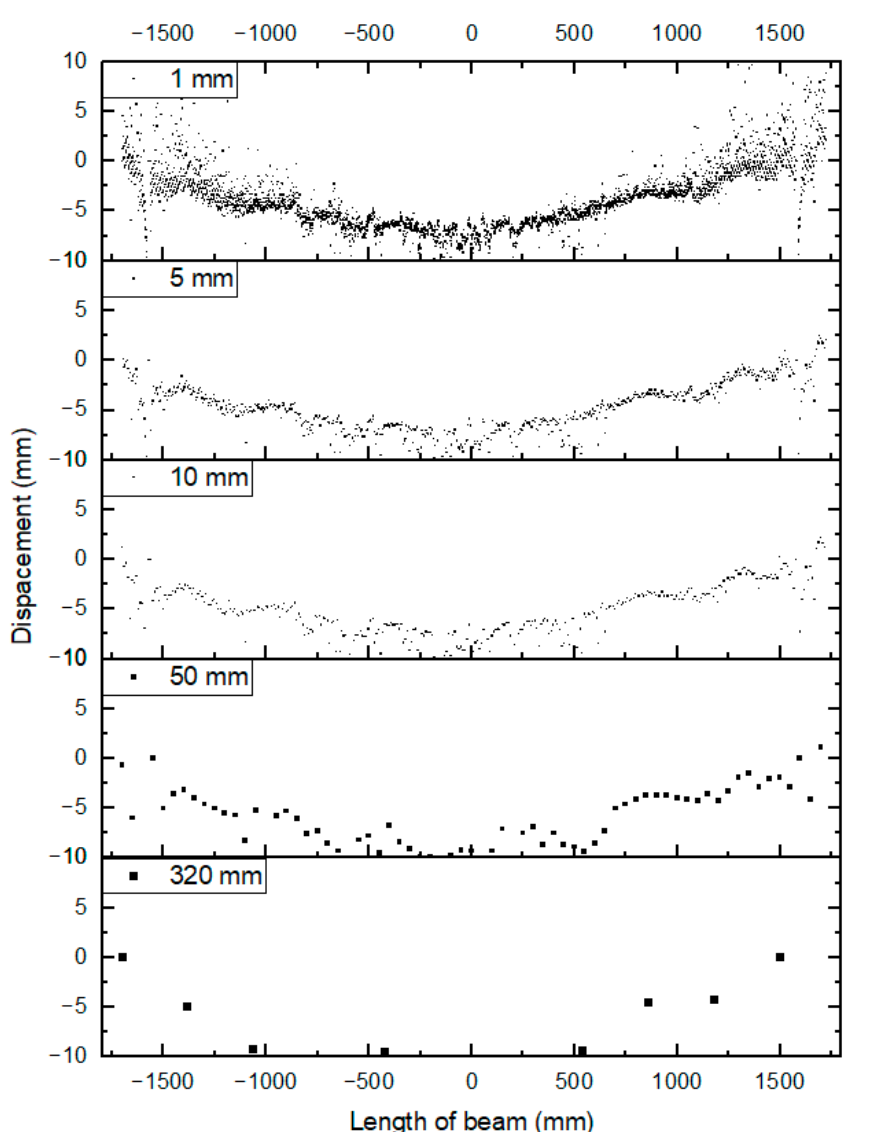
Figure 16. Deflection lines created by scanning at different measuring section lengths (1–320 mm).